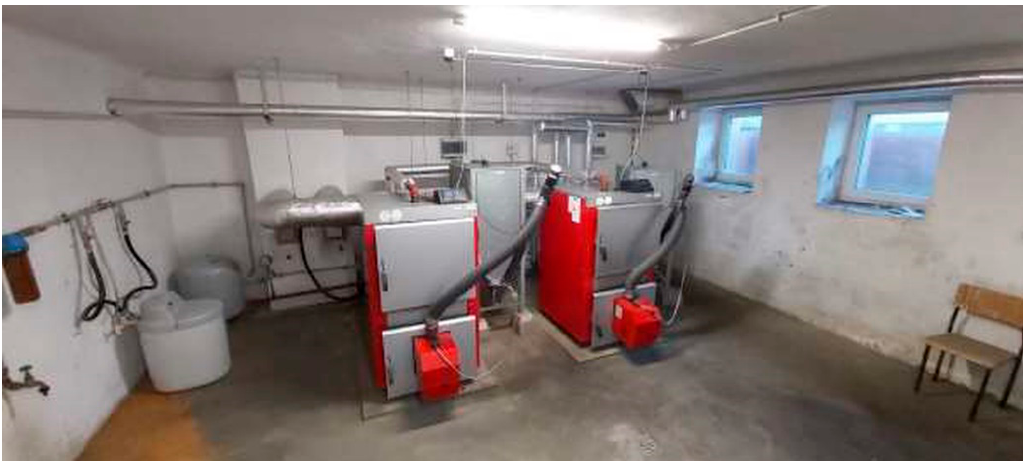
Figure 8. New boiler room.